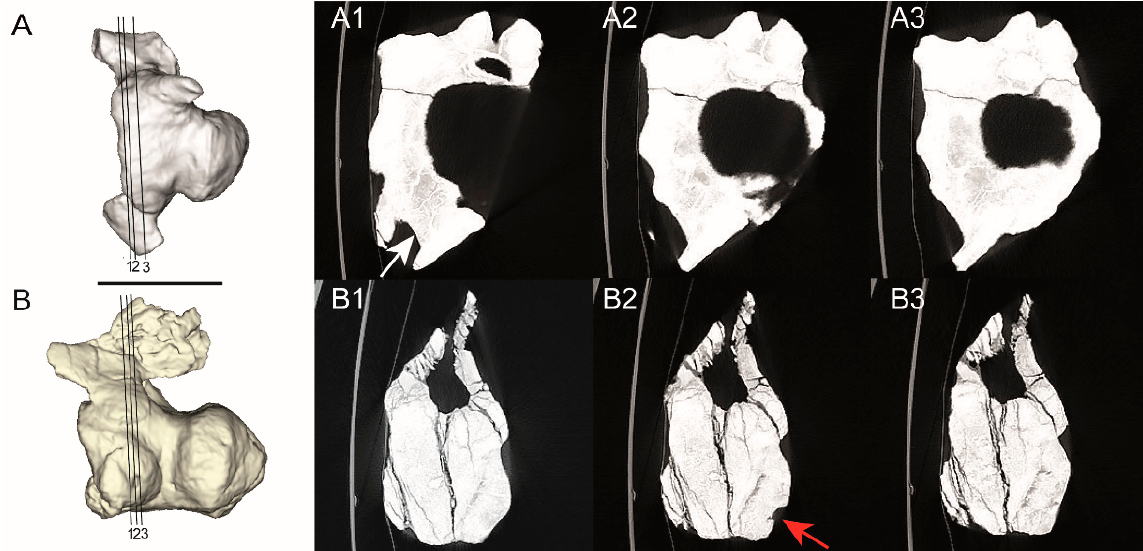
Figure 3. 3D models of the caudal vertebrae and the sequence of CT scan images in the serial axial section for MAU-Pv-LI-601 ( A ) and MAU-Pv-LJ-472/1 ( B ). ( A1 – A3 ) corresponding to the proximal end of the vertebral centrum MAU-Pv-L I-601 and ( B1 – B3 ) corresponding to the proximal end of the vertebral centrum of MAU-Pv-L J-472/1. In ( A1 ) the pathological tissue is marked by a white arrow, and in ( B2 ) the cloaca is marked by a red arrow. Scale bars equal 10 cm.